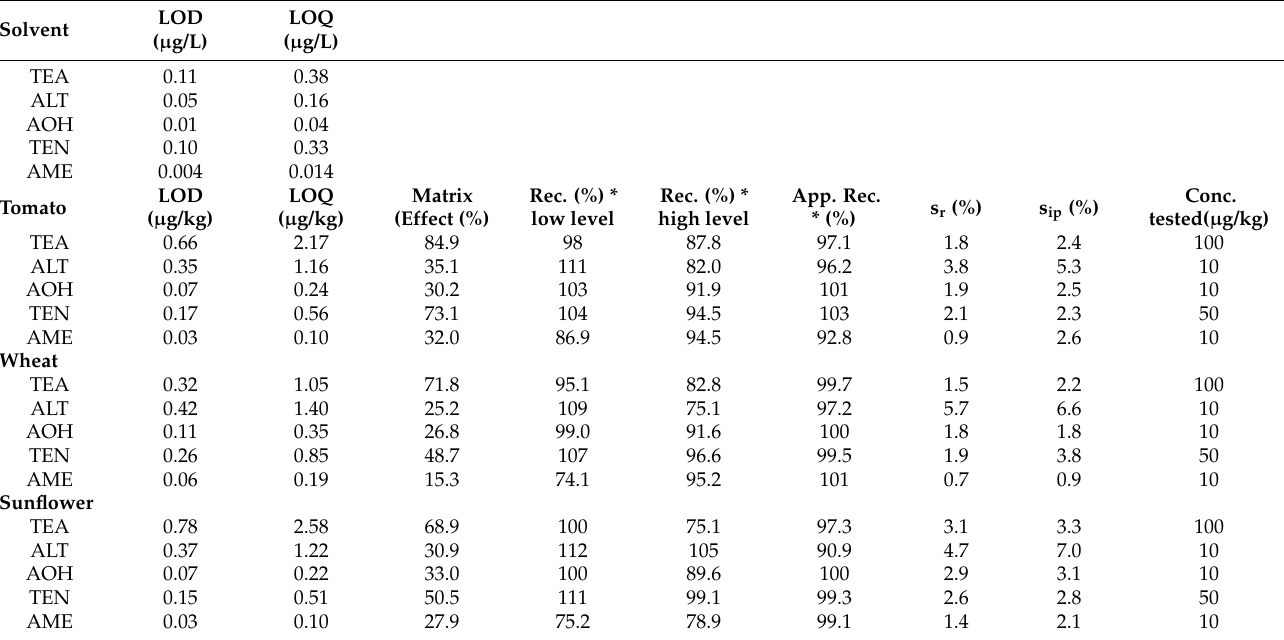
Table 4. Validation figures of merit in the analysis of tomato products, wheat and sunflower